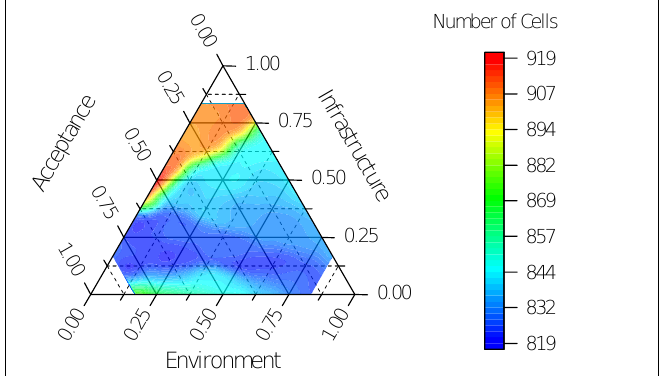
Figure 9. Influence of different weighting factors on the length of the DC GER project. Own